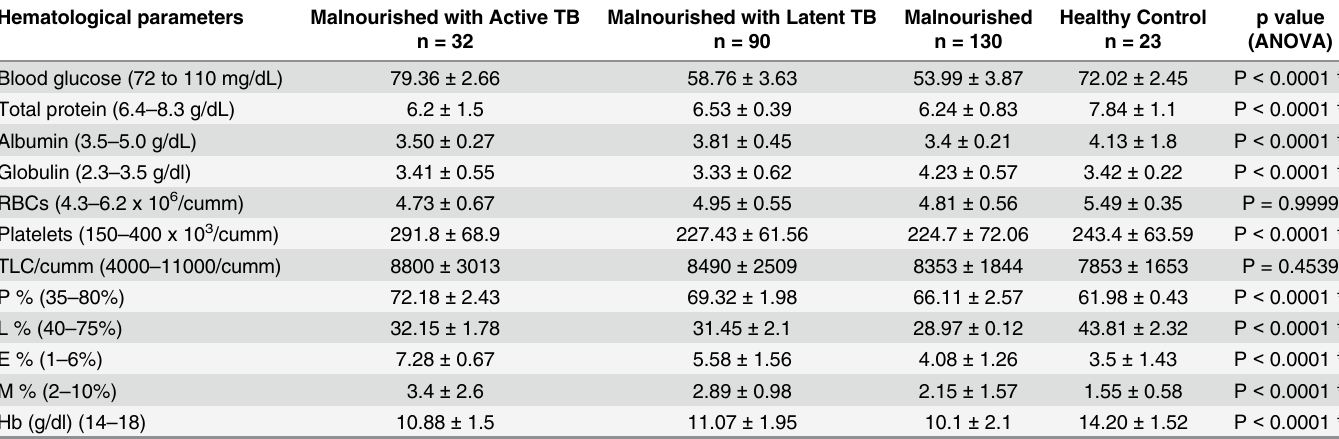
Table 2. Hematological parameters of the population under study. Hematological